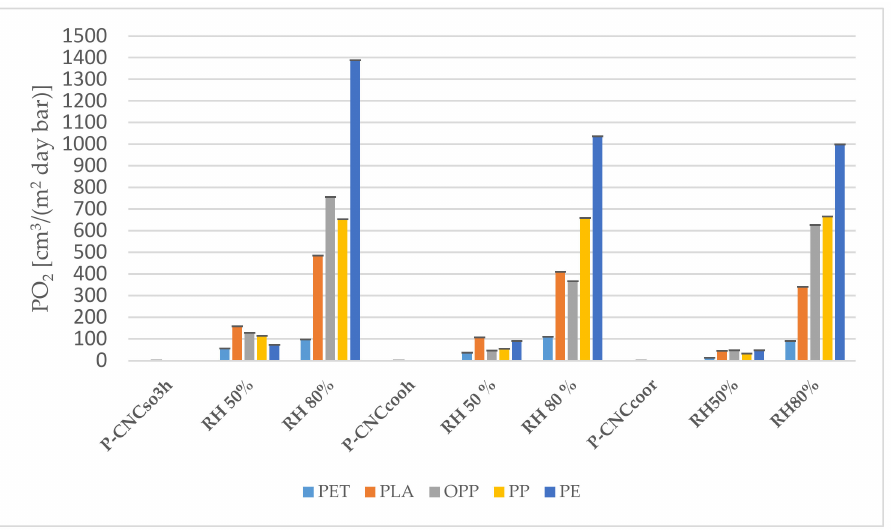
Figure 8. Oxygen permeability of polymers coated with CNC SO3H , CNC COOH and CNC COOR at 50% and 80%